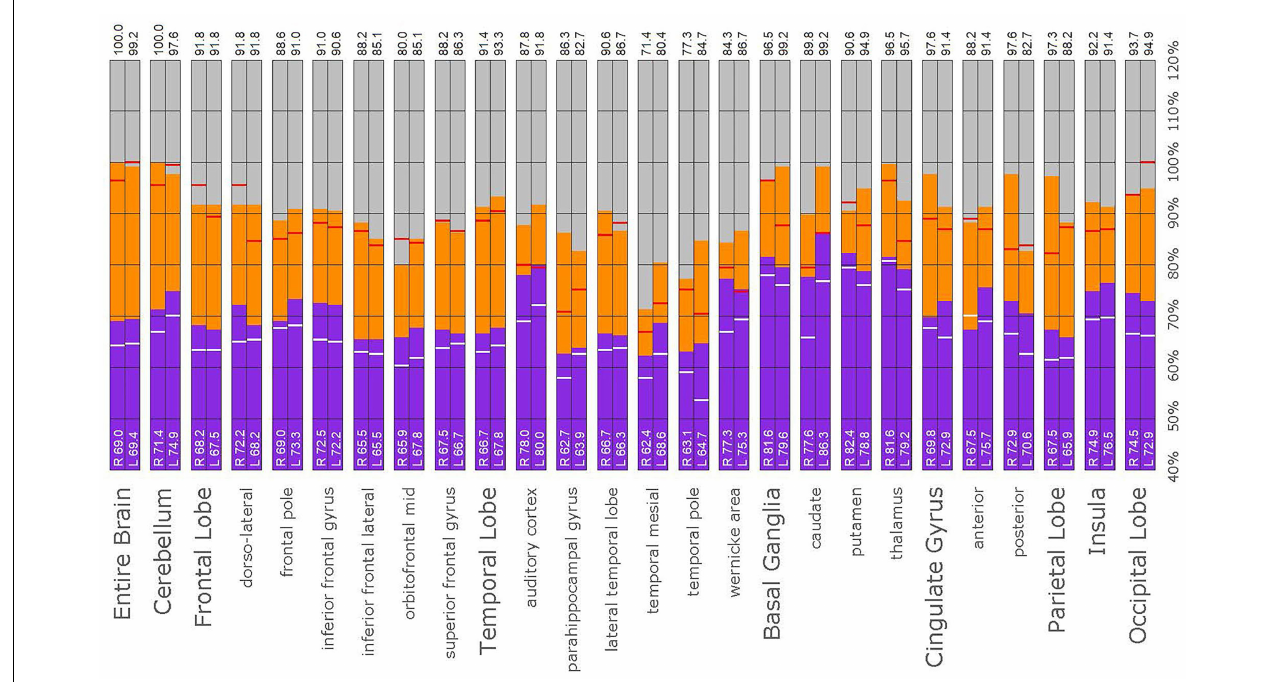
FIGURE 11 | Semi-quantitative region of interest analysis of the SPECT scan of Patient B. Data analysis and presentation is as described in Figure 10 . Perfusion of the thalamus is increased and asymmetrical, although not as obviously as upon inspection of the scan. Perfusion is markedly increased in the left caudate, approaching the maximal count of the cerebellum. Multiple cortical areas of increased perfusion are evident, predominately in the frontal cortices. In many ROIs, the patient’s maximal counts exceed that of the normative sample, though not to the degree seen in the other cases. Portions of the frontal cortex, the lateral temporal lobe, cingulate gyri, the putamen, and the occipital lobe, which show maximal counts less than that of the normative sample, are the exceptions. In all ROIs, the patient’s maximal counts exceed that of the normative sample (red line). In all ROI, the patient’s median counts exceed that of the normative sample, with the exception of the right anterior cingulate gyrus (white